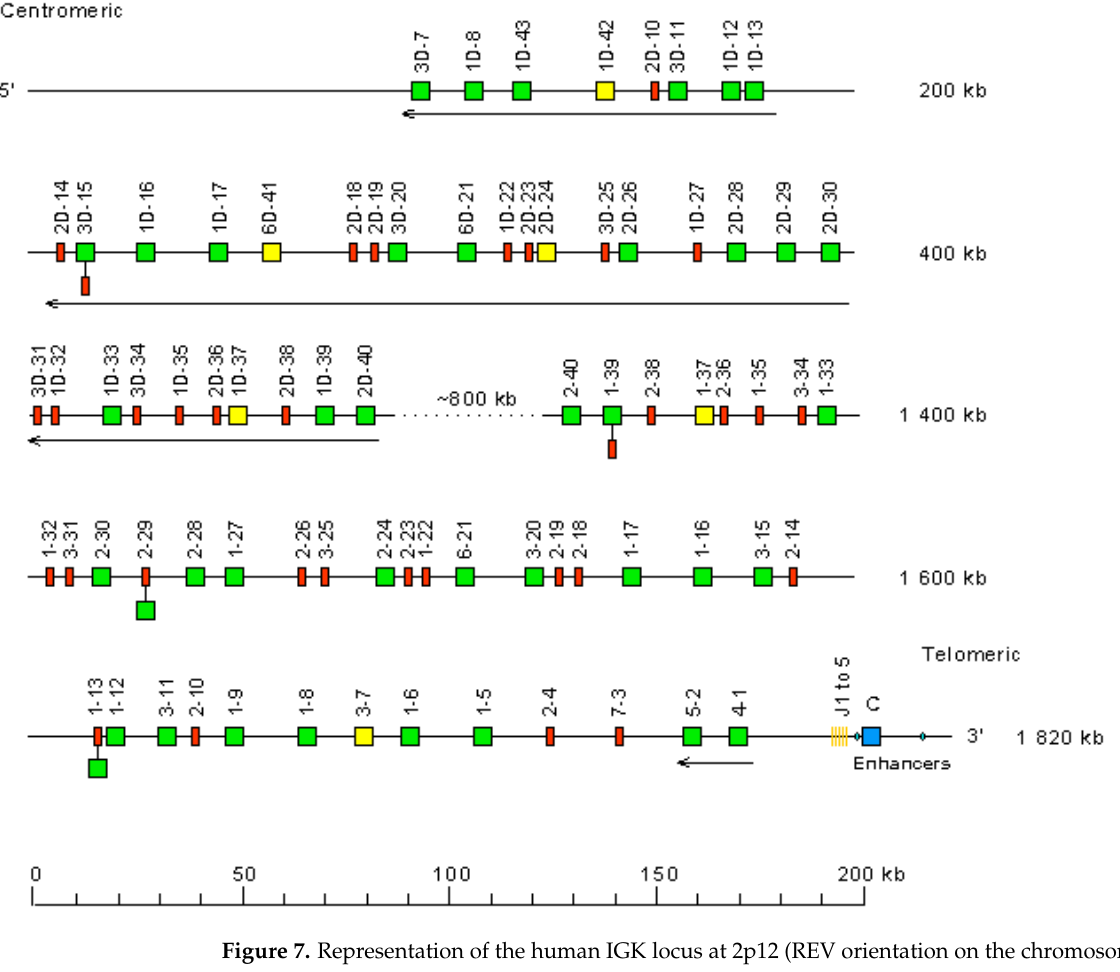
Figure 7. Representation of the human IGK locus at 2p12 (REV orientation on the chromosome) [2,5]. The boxes representing the genes are not to scale. Exons are not shown. The IGKV genes of the proximal V ‐ CLUSTER are designated by a number for the subgroup, followed by a hyphen and a number for the localization from 3 ′ to 5 ′ in the locus. The IGKV genes of the distal duplicated V ‐ CLUSTER are designated by the same numbers as the corresponding genes in the proximal V ‐ CLUSTER, with the letter D added. Arrows show the IGKV genes polarity which is opposite to that of the J ‐ C ‐ CLUSTER [2]. IMGT ® http://www.imgt.org (accessed on 20 February 2022) , IMGT Repertoire